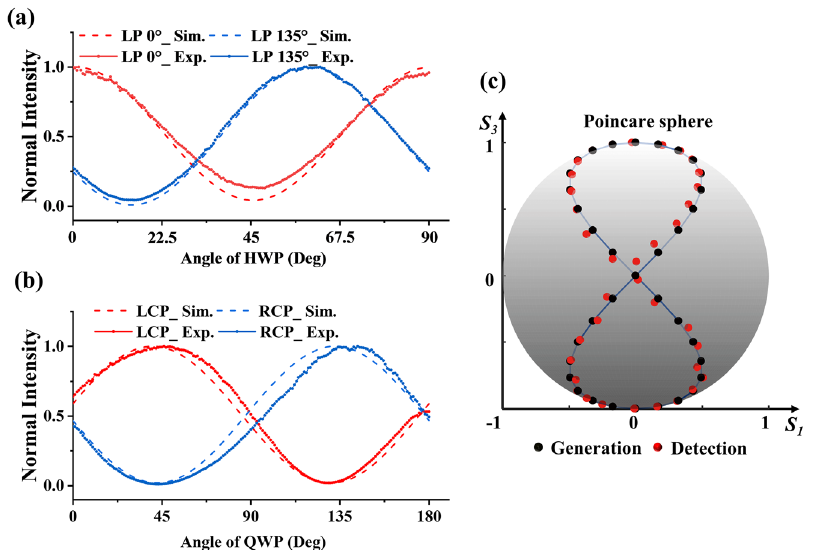
Figure 3: Device characterization for Stokes